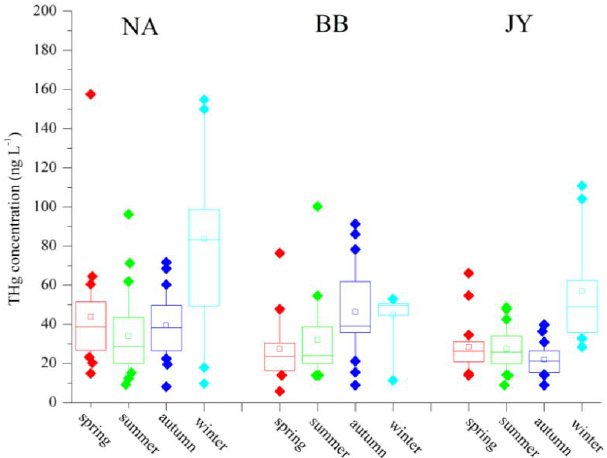
Fig. 2. THg concentrations in all precipitation samples at three sam- pling sites over time. Box plot showing median (solid line), mean (small square), 25th and 75th percentiles (box boundary), 10th and 90th percentiles (whiskers).